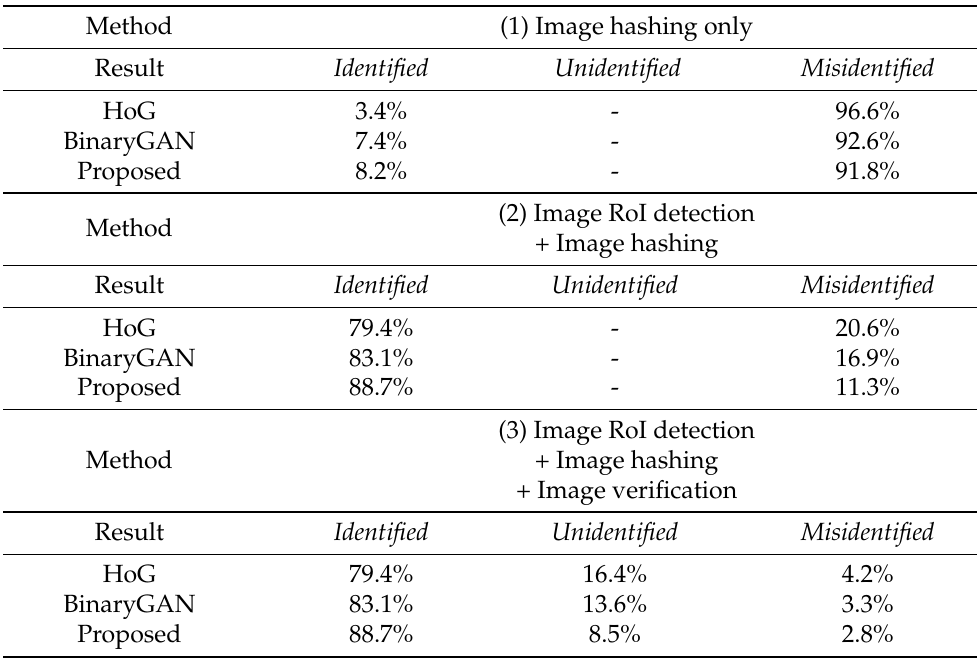
Table 6. Ablation tests of photo copyright identification framework by using HoG [11], Binary- GAN [10], and the proposed image hashing with the binary descriptor size 512. The identification results are divided into identified , unidentified , and misidentified . Identified means the correct identifi- cation, and unidentified defers the image identification. Misidentified is the identification error (false positive rate), which should be